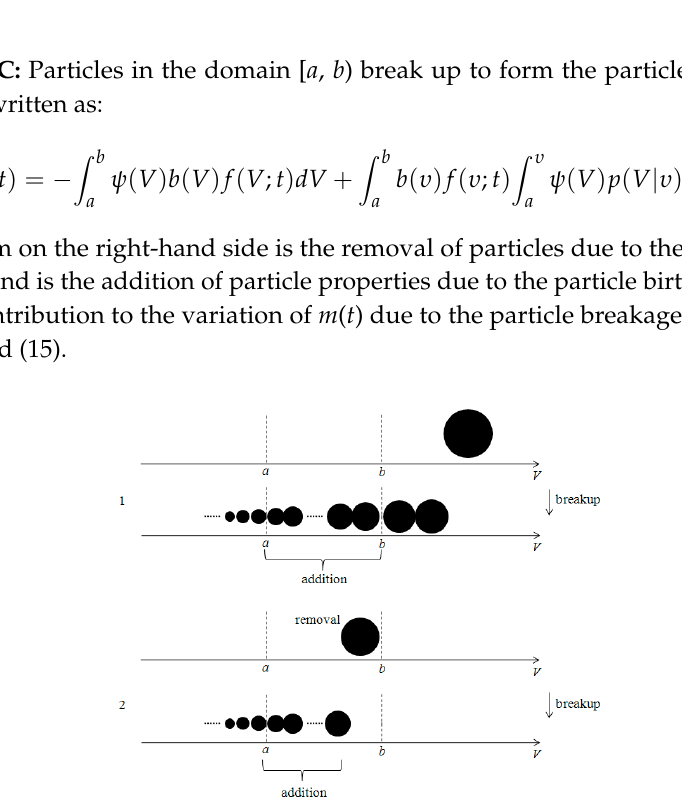
Figure 2. Contribution to the variation of m ( t ) in domain [ a , b ] due to aggregation.